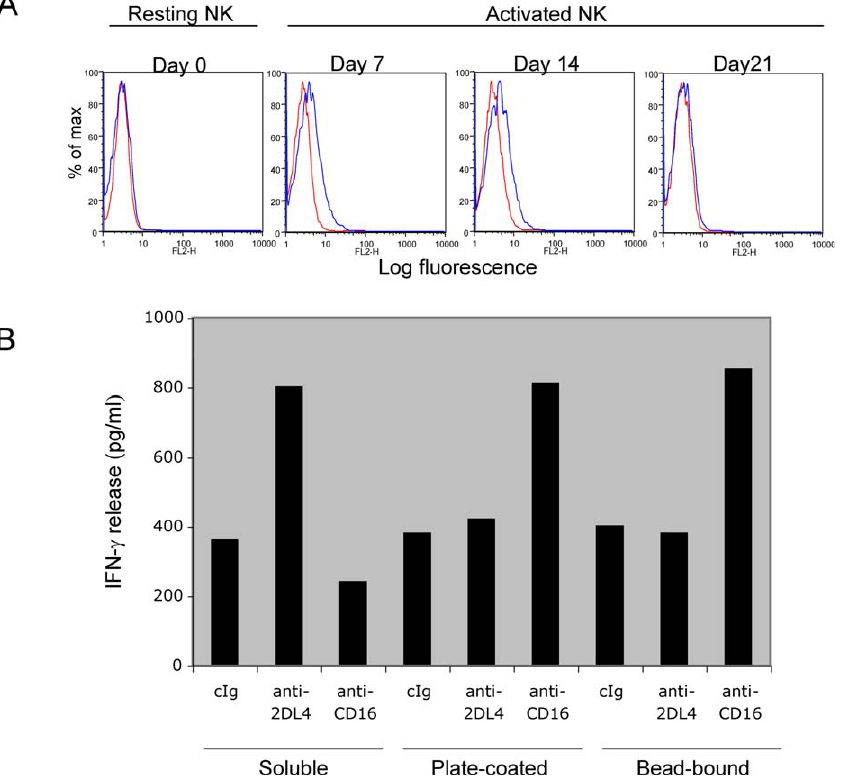
Figure 1. IFN- c Secretion by Resting NK Cells Is Induced by Soluble Antibodies to KIR2DL4 (A) KIR2DL4 expression on the surface of NK cells immediately after isolation (day 0) or after 7, 14, or 21 d in culture with autologous feeder cells and rIL- 2. Cells were stained with mAb 33. (B) Resting NK cells were incubated with soluble (10 l g/ml), plate-coated (5 l g/0.1 ml/well), or bead-bound (4 beads/cell) antibodies to KIR2DL4 (mAb 33) or CD16 (mAb 3G8). After 24 h, culture supernatants were tested by ELISA for IFN- c